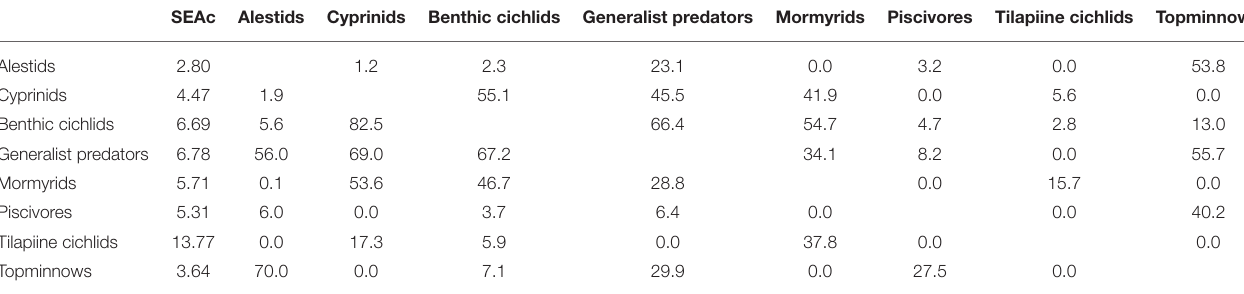
TABLE 4 | The core isotopic niche area (SEAc) and percent overlap between fish groups in Lake Liambezi in